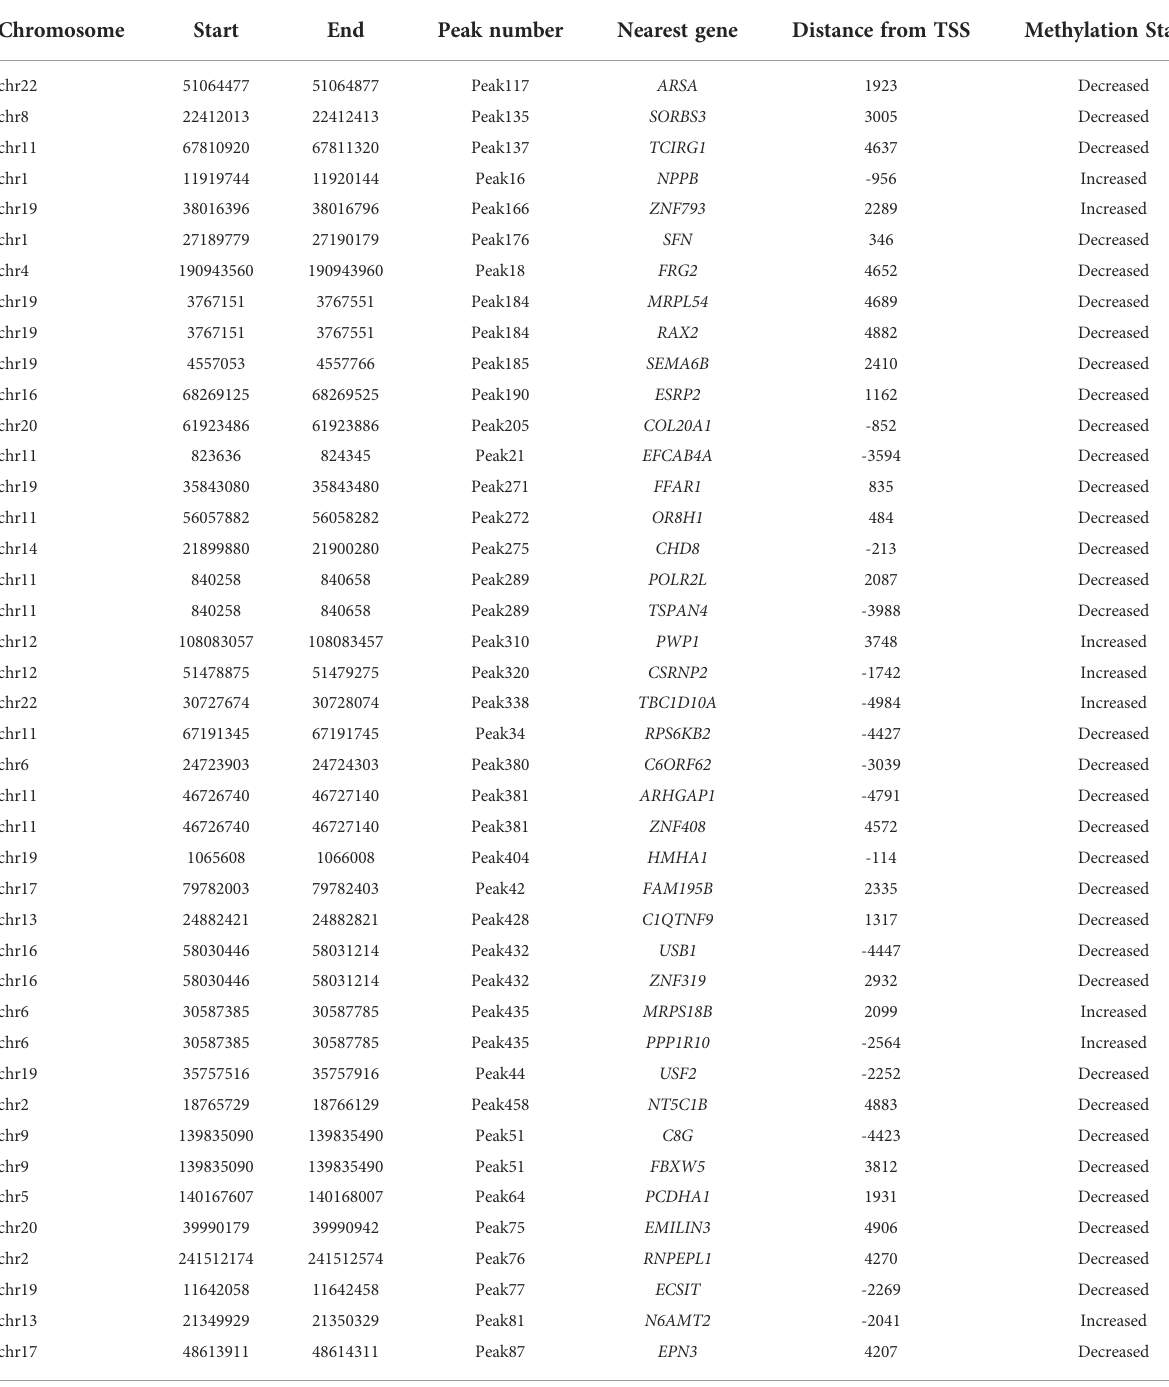
TABLE 3 Signi fi cant peaks that are differentially methylated between T2D and